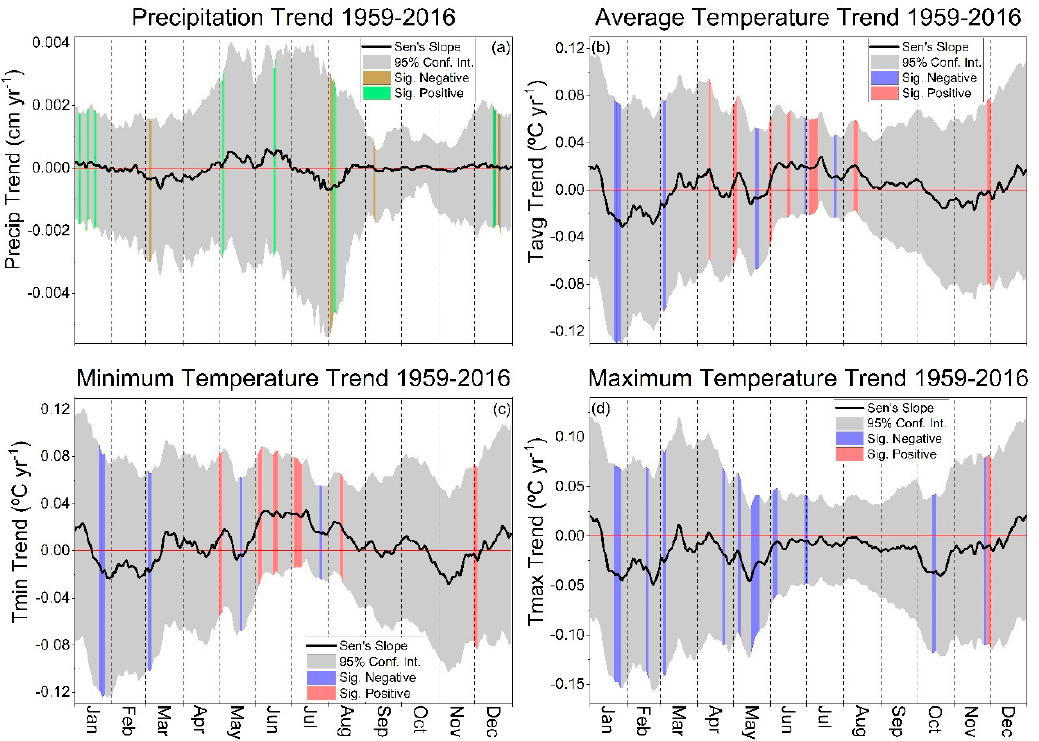
Figure 5. Centered three-week moving averages of ( a ) daily precipitation, ( b ) average temperature, ( c ) minimum temperature, and ( d ) maximum temperature trends averaged across all eighteen stations between 1959 and 2016. Grey shading represents the 95% confidence interval. Brown and green (red and blue) shading represents statistically significant (p < 0.05) daily precipitation (temperature) trends.